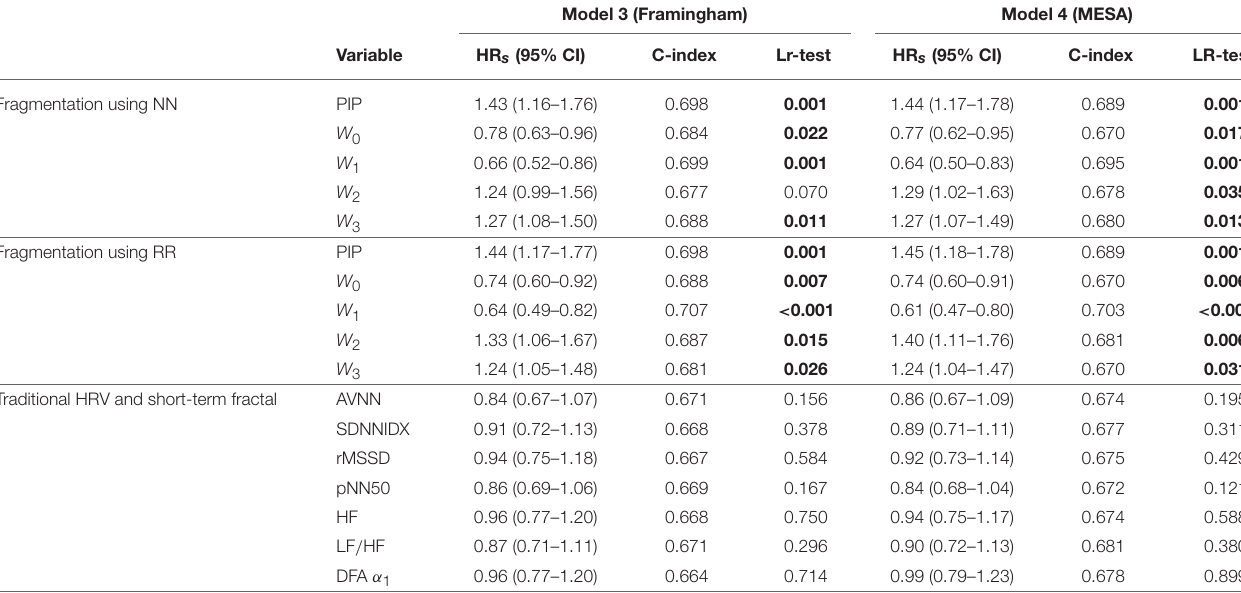
TABLE 3 | Association of fragmentation, traditional HRV and short-term fractal indices with incident CVEs in models adjusted for the Framingham (model 3) and MESA (model 4) risk